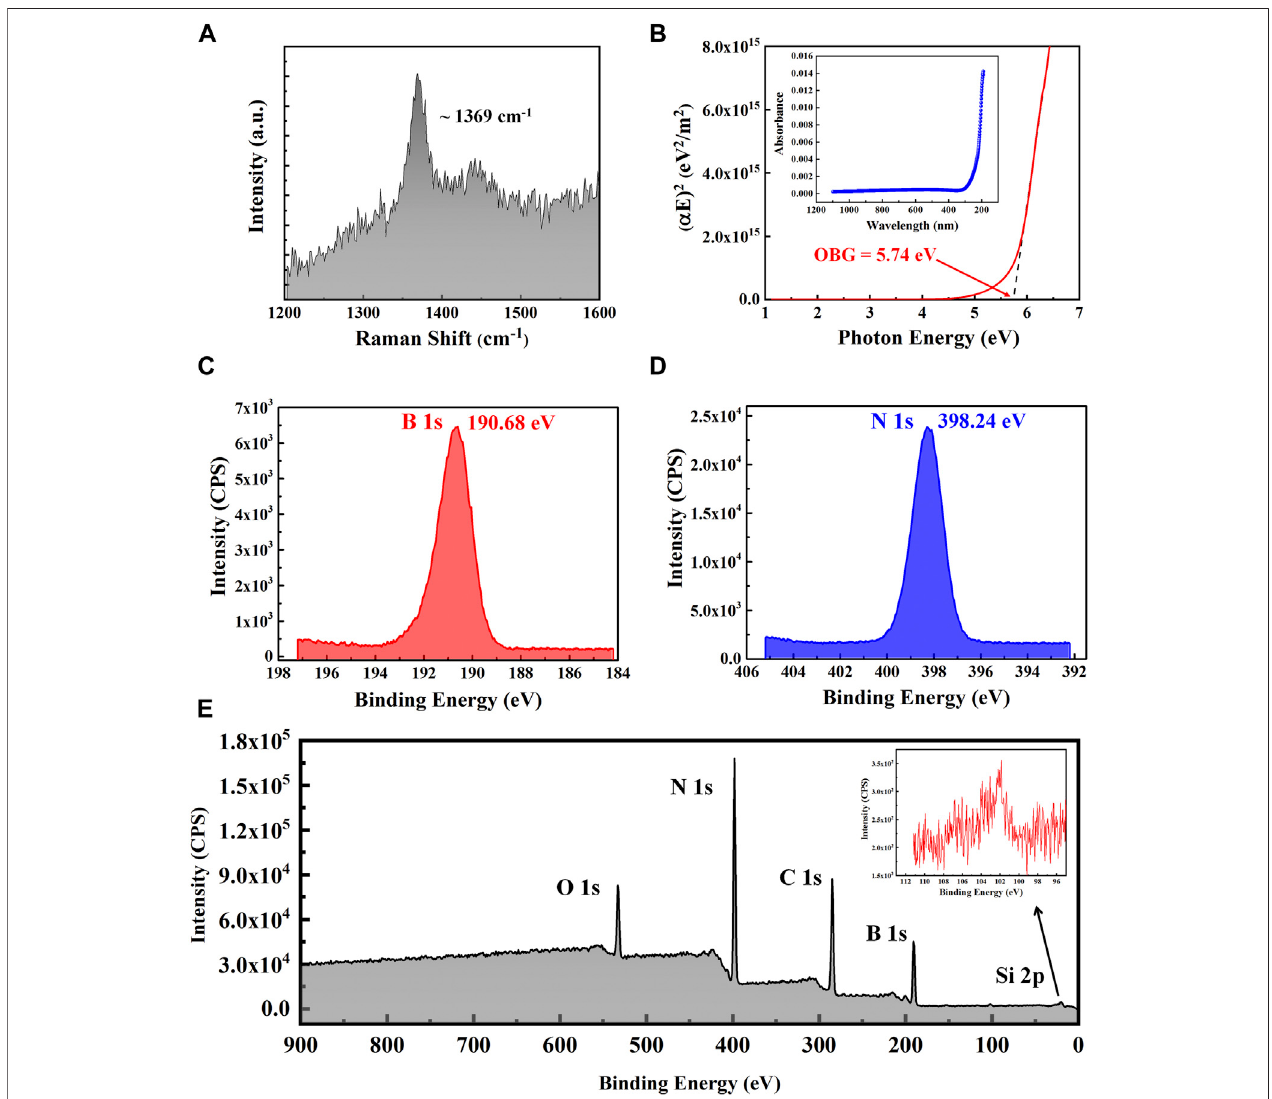
FIGURE 2 | Characterizing of h -BN samples. (A) Raman spectrum of the h -BN sample transferred on a SiO 2 /Si substrate. (B) The optical band gap analysis and insetis UV-visible absorption spectrum. (C) B1s and (D) N1s XPS spectra of the h -BN sample, respectively. (E) XPS survey spectrum ofthe h -BN on SiO 2 /Si substrate. The inset displays the XPS spectrum of Si